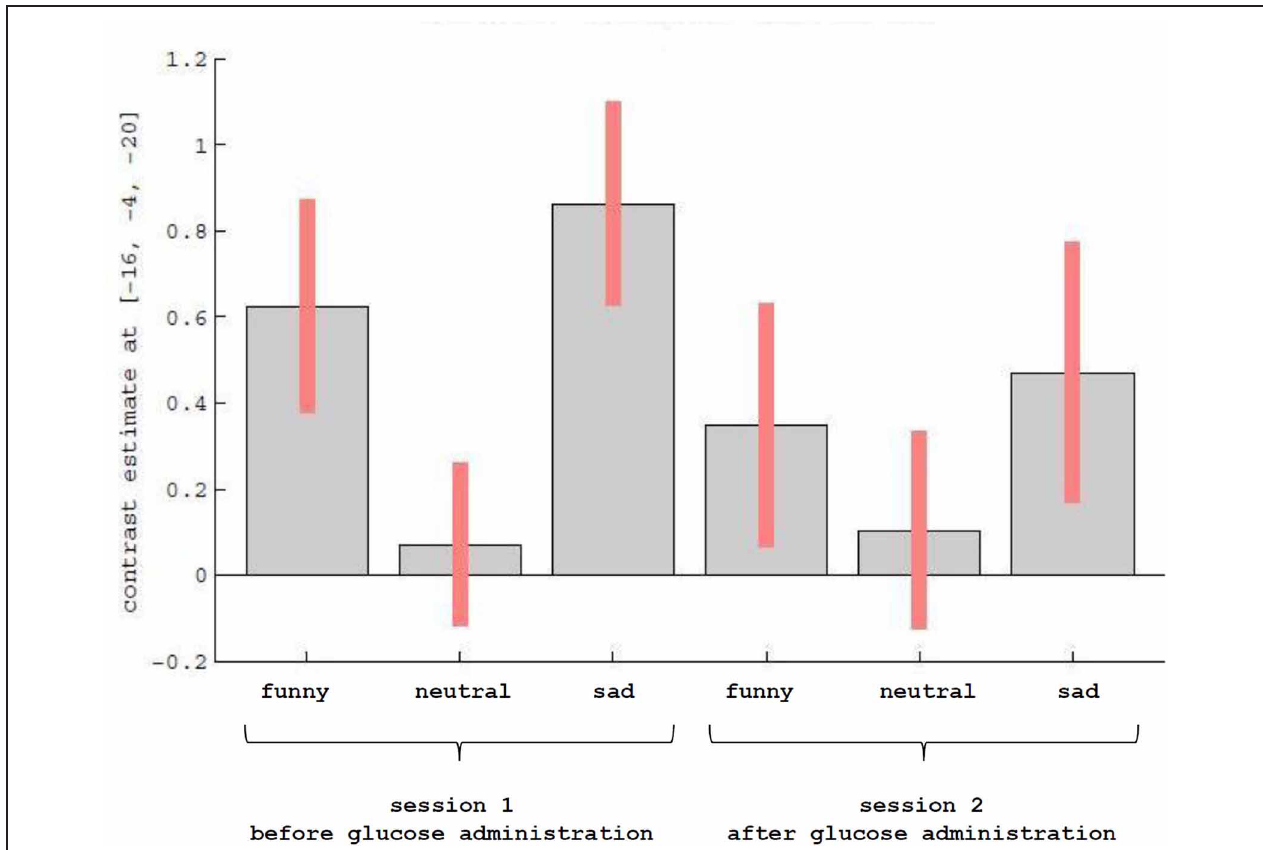
FIGURE 2 | Description of contrast estimates for the results of the main effect of emotional categories, as shown in Figure 1 in the left amygdala.